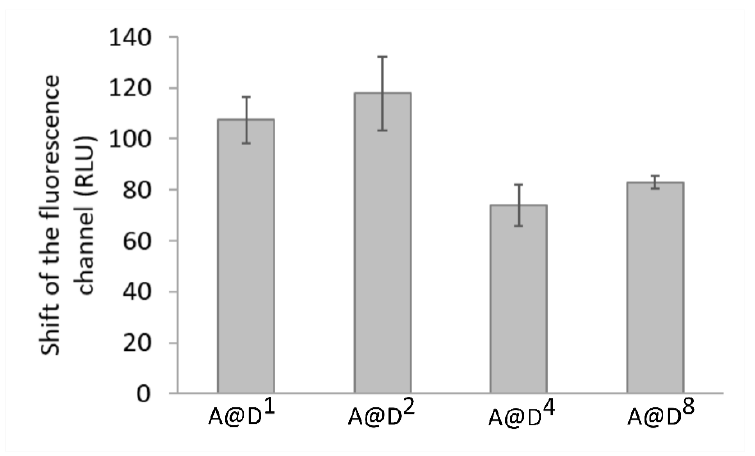
Figure 6. Shift of the mean fluorescence channel of A@D 1 , A@D 2 , A@D 4 , and A@D 8 encapsulates in relation to conjugates without ALA (D 1 , D 2 , D 4 , and D 8 , respectively). Fluorescence detection wavelength was 605 nm. Data are presented as means ± SD.